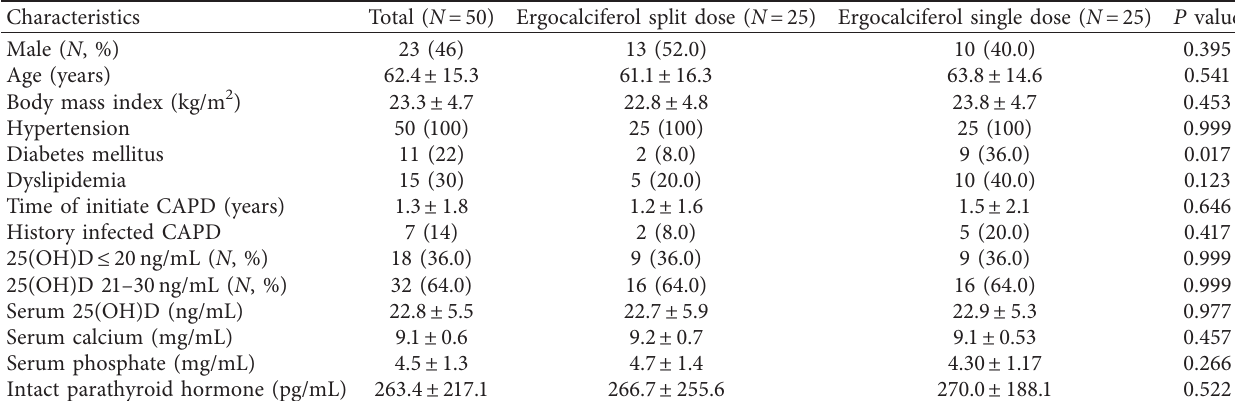
Figure 2: Study flow diagram. Table 1: Baseline characteristics.